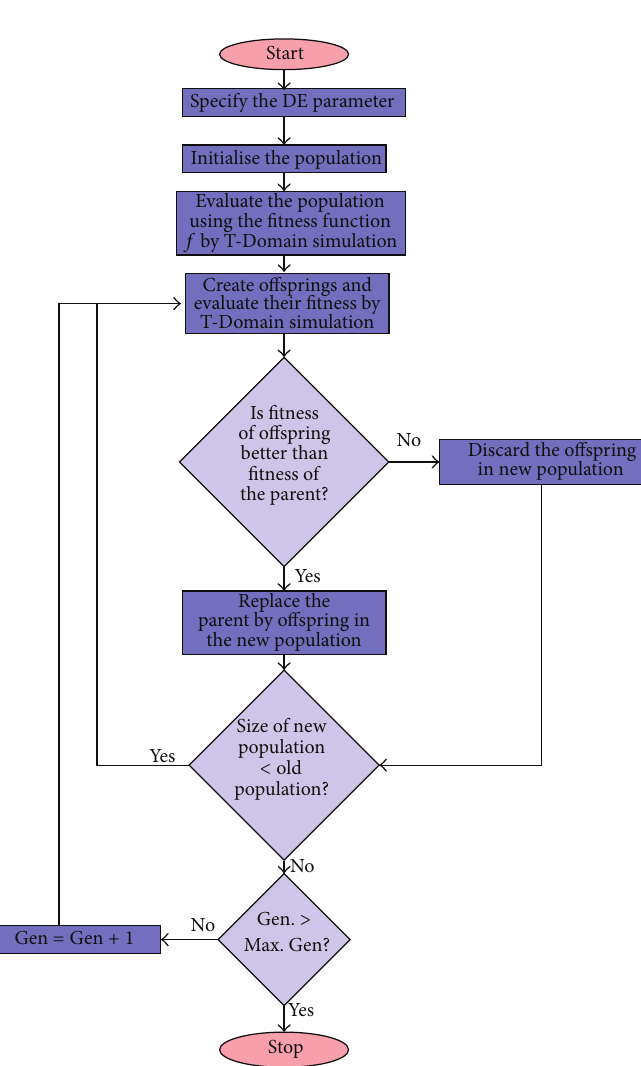
Figure 2: Flow Chart for differential evolution